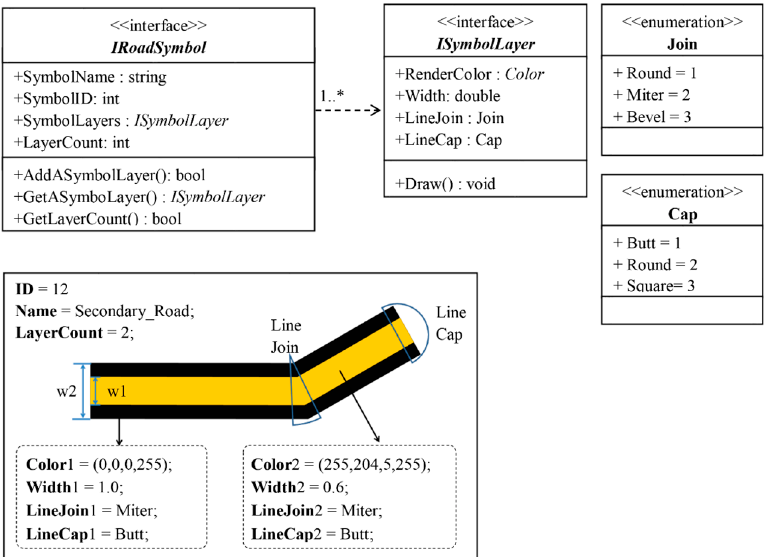
Figure 5. Design of the symbol description interface.